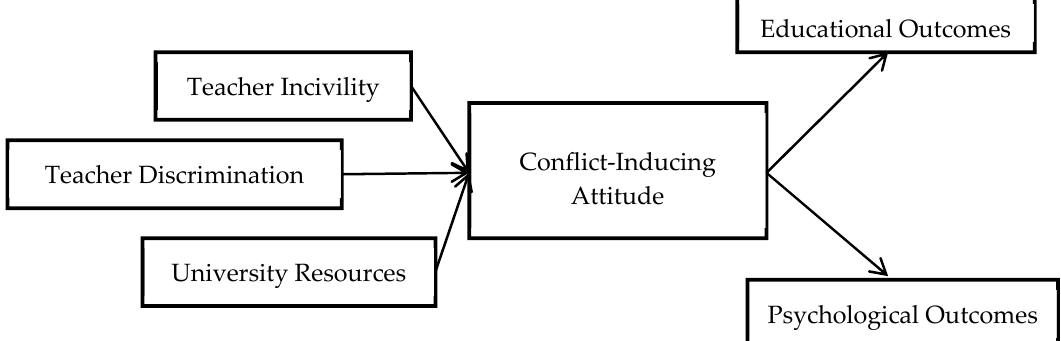
Figure 1. Conceptual model of this study.